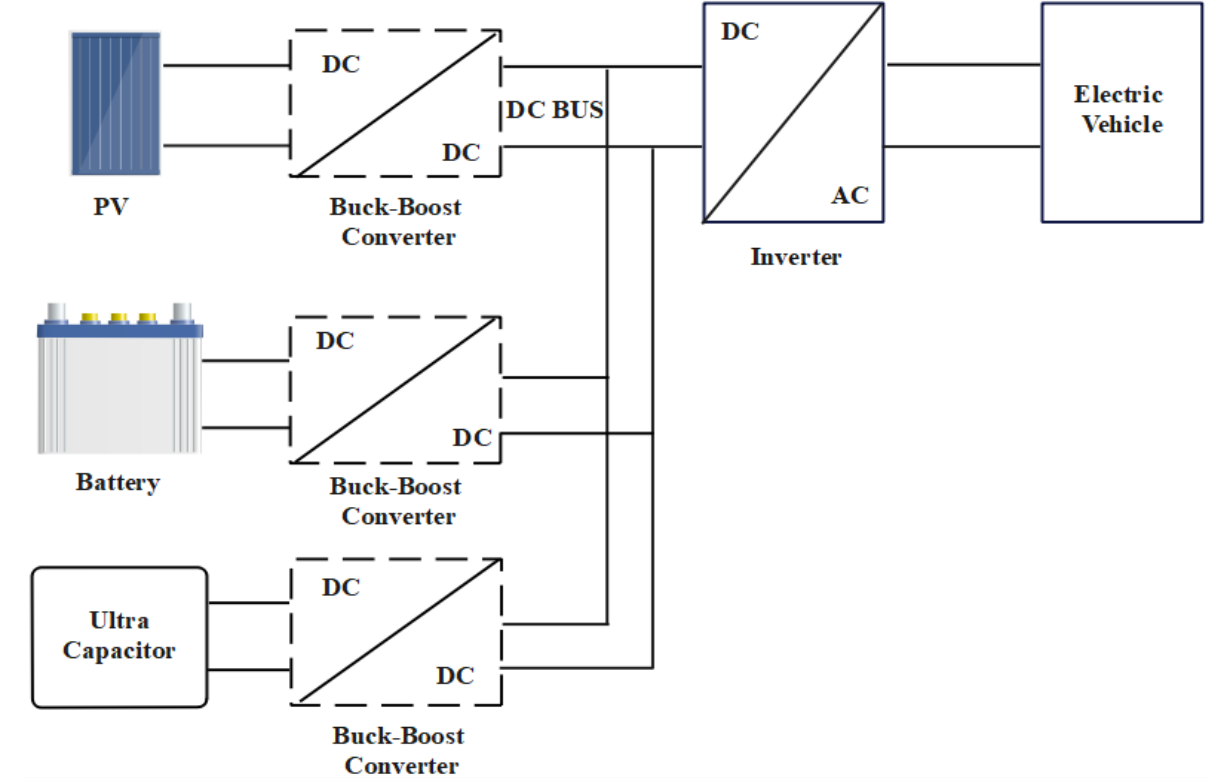
Figure 4. Overall block diagram of the analyzed EMS for an electric vehicle.